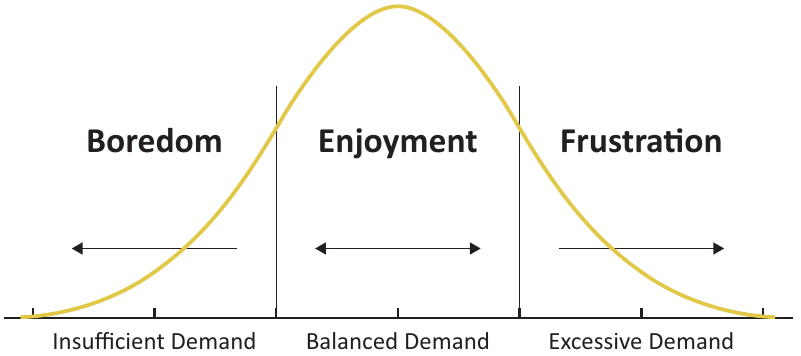
Figure 3. The full spectrum of demands as dimensions. Notes: The majority of gamers will fall into the middle section dur- ing the majority of their gameplay experience, which is what most demand research covers. The two extremes represent demand configurations that, if held for a significant period of time, could cause problematic behaviour (i.e., trolling). Media and Communication, 2019, Volume 7, Issue 4, Pages